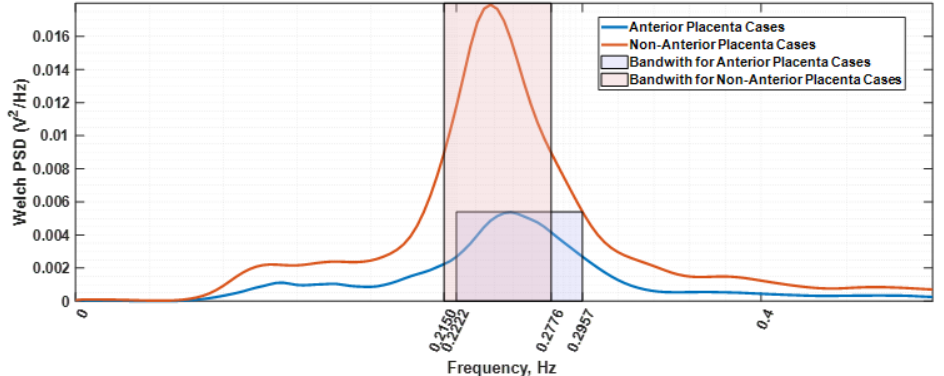
Figure 2. Welch periodogram estimations of the average spectra for the contraction’s subjects with anterior (blue colour) and non-anterior placenta (orange colour). The respective bandwidths are shown in the shadow rectangular areas.